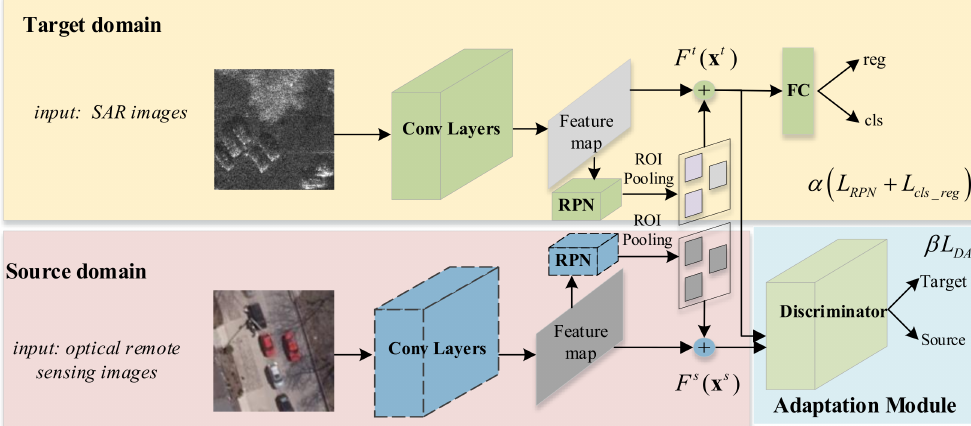
Figure 1. The architecture of the domain adaptive Faster R-CNN for source and target domain data, i.e., the optical remote sensing images and SAR images. In the domain adaptation module, the features of two domains are constrained with the GAN